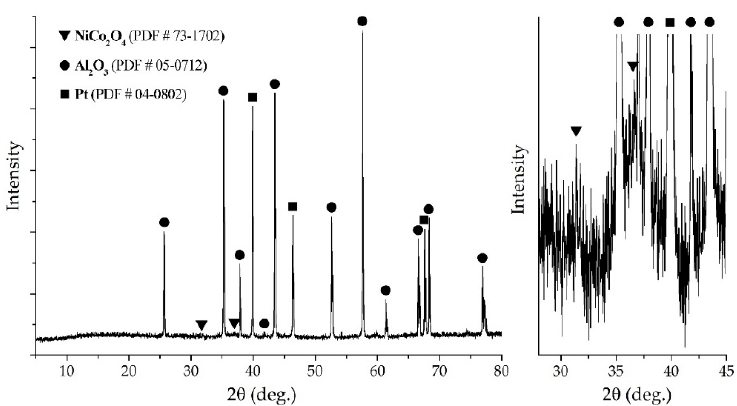
Figure 7. XRD patterns of hierarchically organized NiCo 2 O 4 films printed on the Pt/Al 2 O 3 /Pt chip surface (left: 5°–80°, signal accumulation time of 0.3 s; right: 28°–45°, 2.0 s).